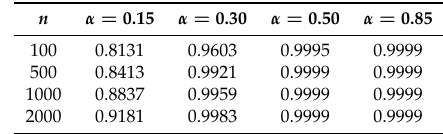
Table 2. Spearman’s correlation for different values of the α parameter and different sizes of the network.